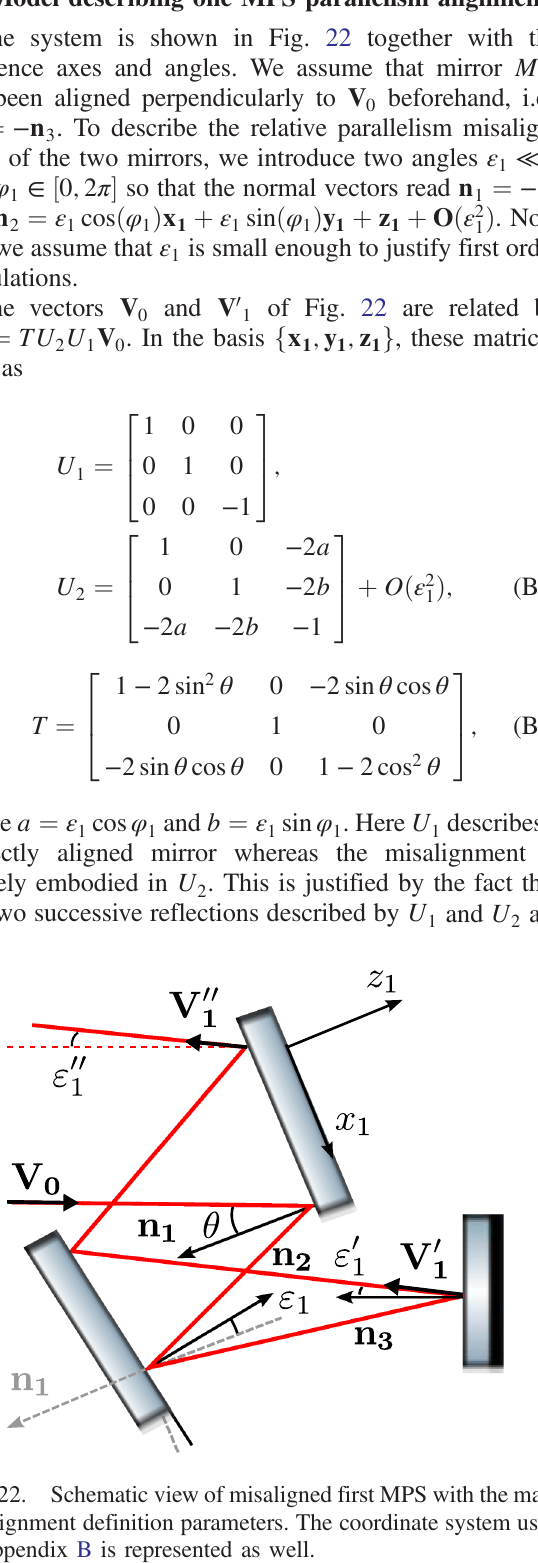
misalignment definition parameters. The coordinate system used in Appendix B is represented as